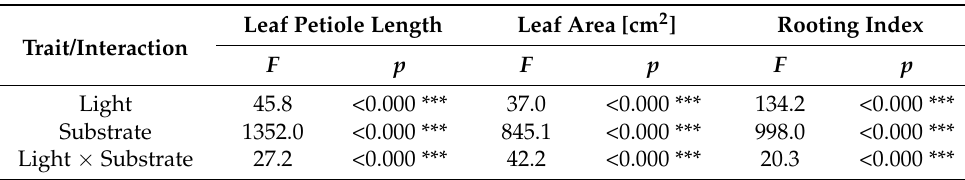
Table 3. F - statistic from a two-way analysis of variance for light treatment and substrate type during the ex vitro growth of rhubarb ‘Raspberry’ in the greenhouse.